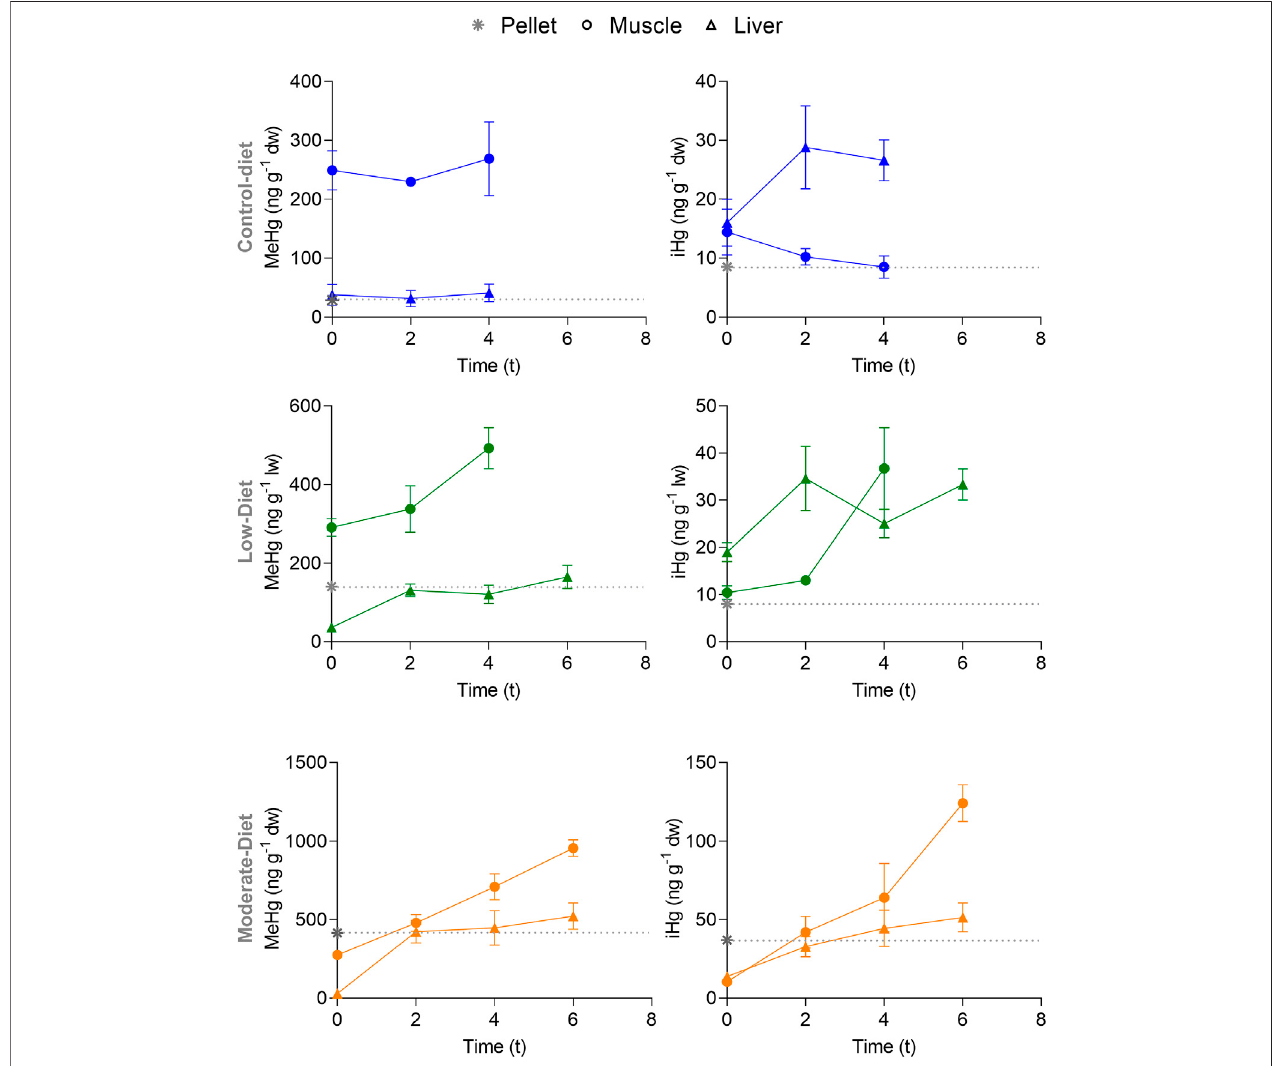
FIGURE2| TemporalvariationofMeHgandiHgconcentrations(inng g − 1 dw)inmuscle(circle)andliver(triangle)ofseabass Dicentrarchuslabrax exposedtothree distinct diets (Control in blue, Low in green, and Mod in orange) containing increasing concentration in MeHg. Data are represented as mean ± standard error. Time is expressed as t , indicating the number of weeks from the beginning of the experiment, after the acclimation period. The gray asterisk represents the MeHg and iHg concentrations in the Control diet (pellet). The gray dotted line represents the MeHg and iHg concentrations at t 0 .